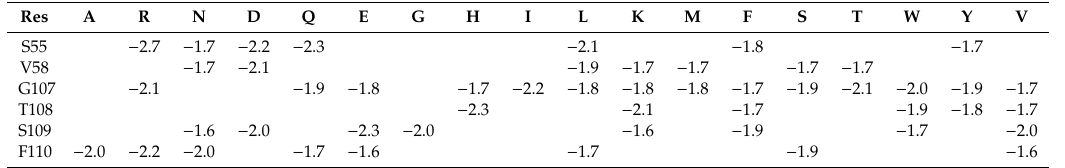
Table 2. Top 50 consensus Z-scores ( < 0) for single mutants 1